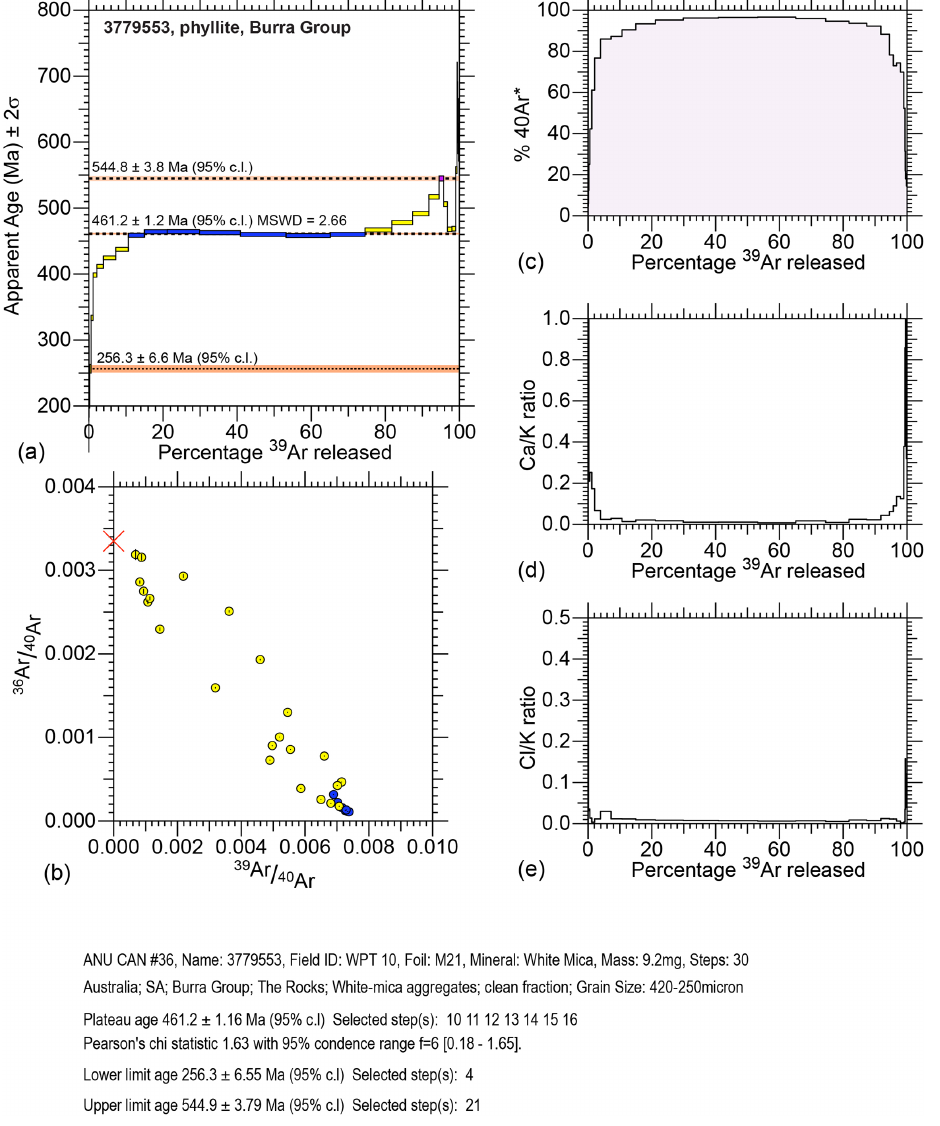
Figure C1. Sample 3779553 (a) age spectrum, (b) isotope correlation diagram, (c) percentage radiogenic 40 Ar ( 40 Ar ∗ ), (d) Ca / K ratio, and (e) Cl / K